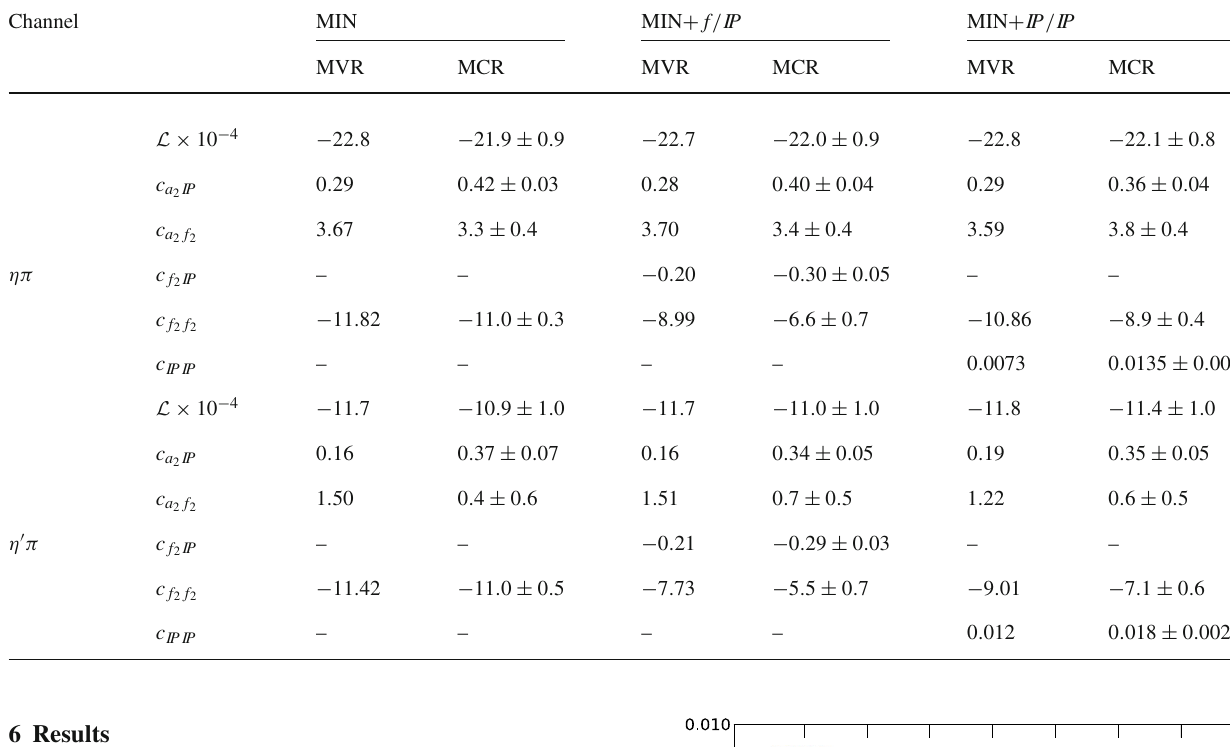
and dispersion of the best ENLL for each pseudodataset. The L distri- butions are depicted in Fig. 11, while the parameter distributions are discussed in Appendix F